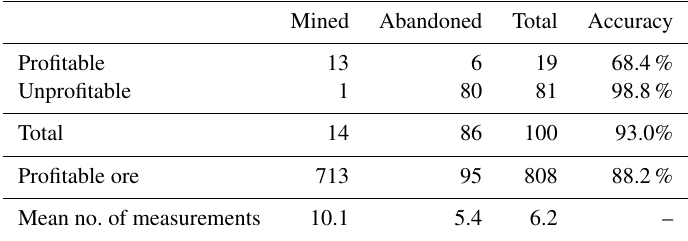
Table 6. Multi-body POMCPOW results with action constraints.